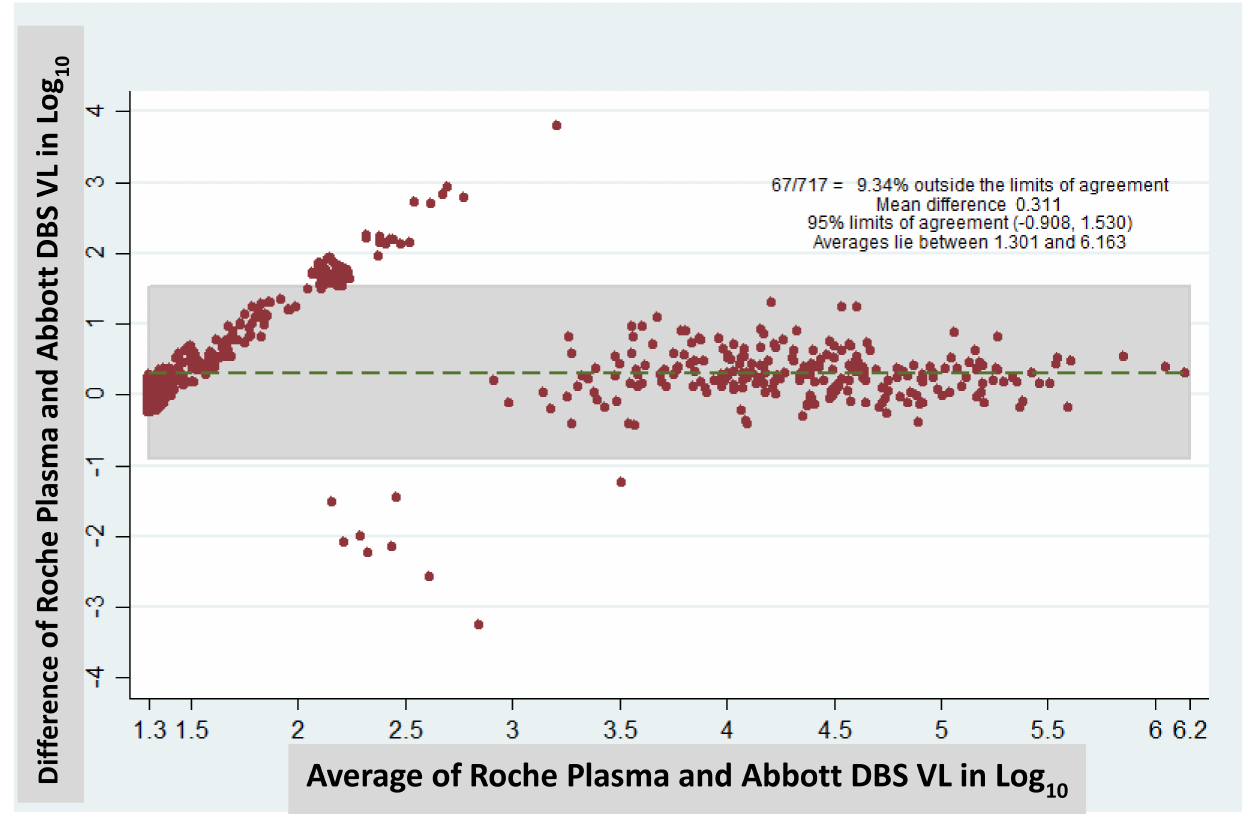
Fig 1. Bland-Altman analysis of Roche plasma VL and Abbott DBS VL among children on ART in